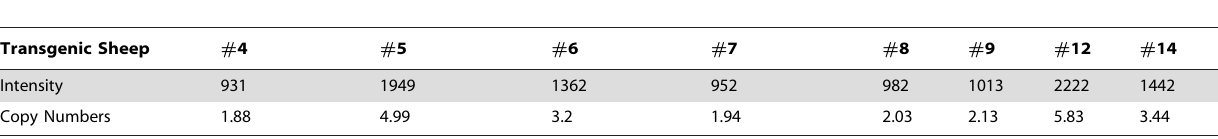
Table 1. Southern blot analysis of transgene copy numbers determined by standard curve with a double-digested genomic DNA sample.